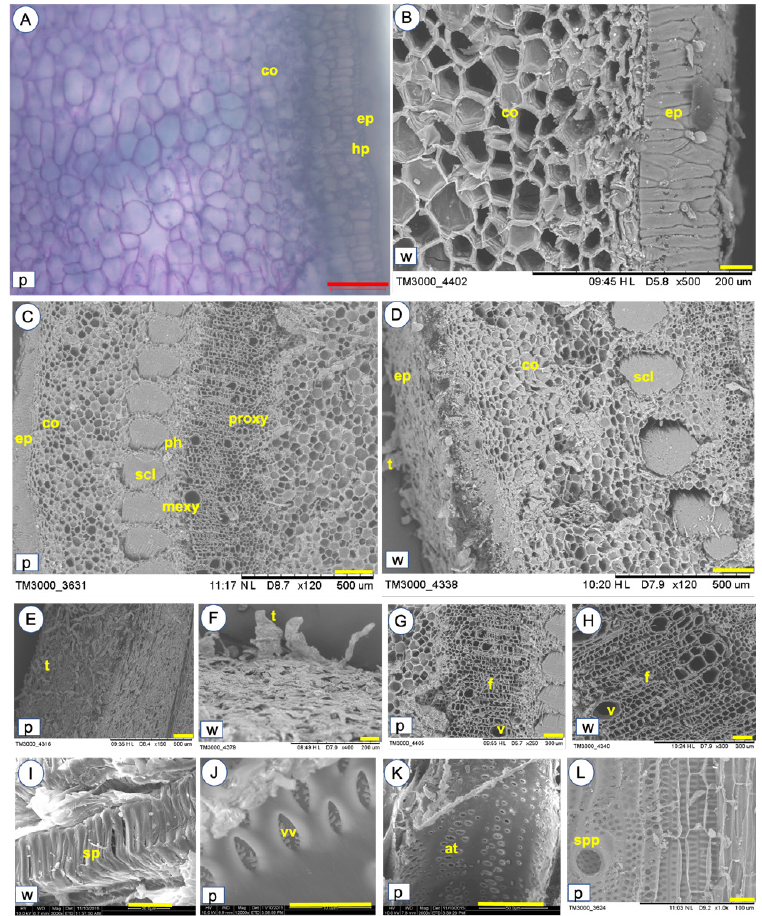
Figure 5 : SEM and LM of stem anatomy of the two flower colour forms of Calotropis gigantea. Except for B, D, F, H, and I, all figures are taken from the purple form. (A) soft and corky bark. (B) TS of stem epidermis showing the wax deposition. (C) TS of stem showing multi-seriate hairs. (D) TS of stem highly packed barrel to rectangular shaped cells. (E) thick coat of epidermis of stem consists of different shapes (leafy, elongated) hairs. (F) leaf-like trichomes of white form. (G) a vascular system of purple form. (H) a vascular system of white form: (I) annular thickenings of the white stem. (J) vestured inter-vessel pits. (K) alternate thickenings (L) LS showing simple perforation plate with a wide and prominent rim. Sub-figure letters: p - purple. w- white. Abbreviations used: op: opposite pitting in the surface. at: annular thickenings. co: cortex. ep: epidermis. f: fiber. mexy: metaxylem. op: opposite thickenings. ph: phloem. proxy protoxylem. scl: sclerenchyma. spp: simple perforation plate. v: vessel. vv: vestured vessel pits. x: xylem. Scale bar: 10 µm: J; 20 µm: I; 50 µm: K; 100 µm: A, L; 200 µm: B, F; 300 µm: G, H; 500 µm: C, D,